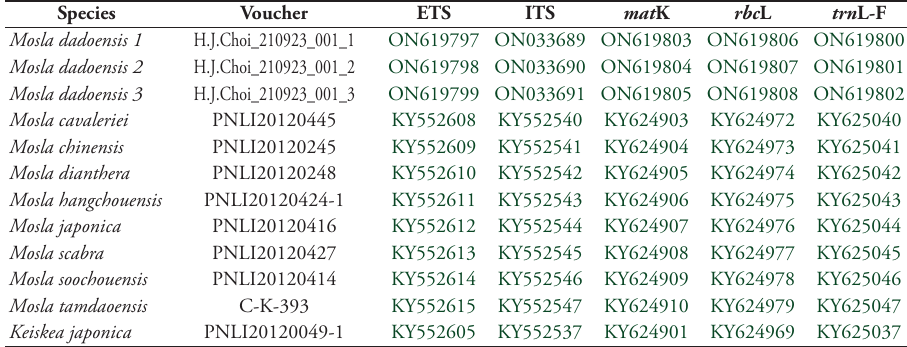
Table 2. List of voucher information and GenBank accessions of species used in this study. Species Voucher ETS